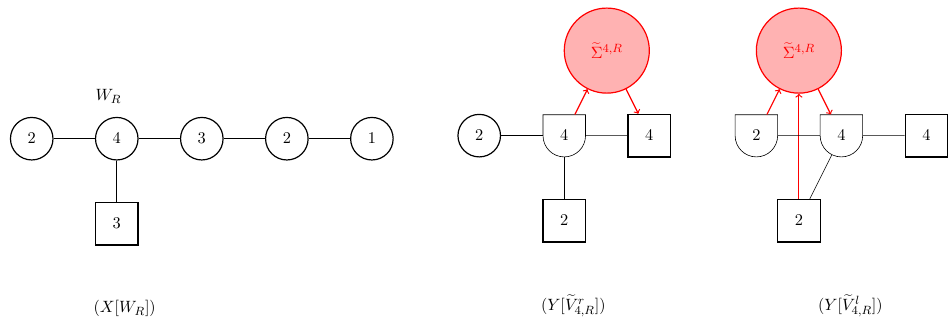
Figure 40 . A gauge Wilson defect in the theory X and the dual vortex defect, realized by the deformation of two different 3d-1d quivers — Y [ e V r